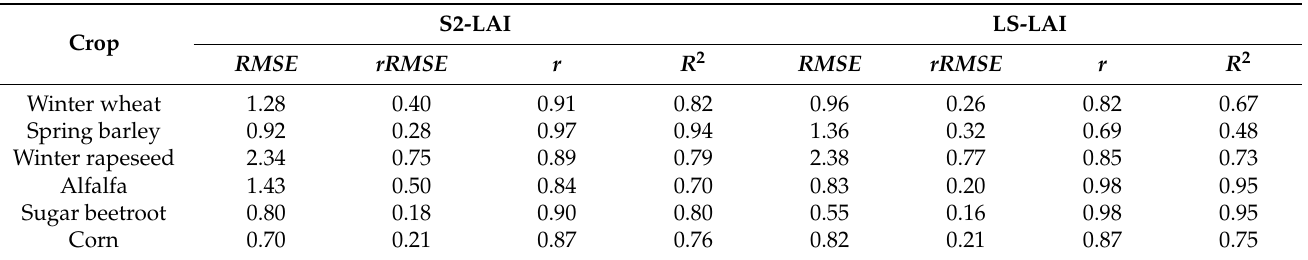
Table 3. Validation metrics of Landsat and Sentinel-2 LAI estimations against in situ data on the level of individual crops.